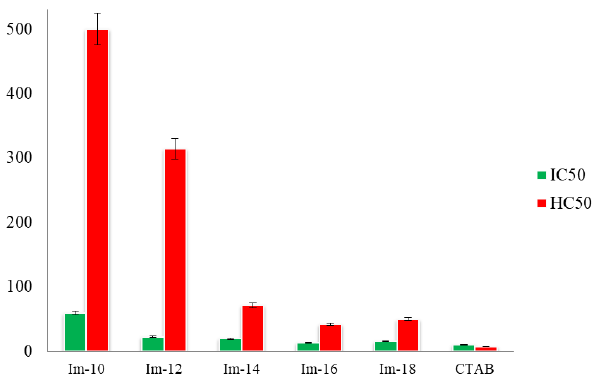
Figure 6. Hemolytic and cytotoxic activity of the monocationic imidazolium surfactants. The data are presented in the values of HC 50 (μM) and IC 50 (μM). Table 3. Evaluation of of selectivity of dicationic and monocationic imidazolium surfactants against S. aureus